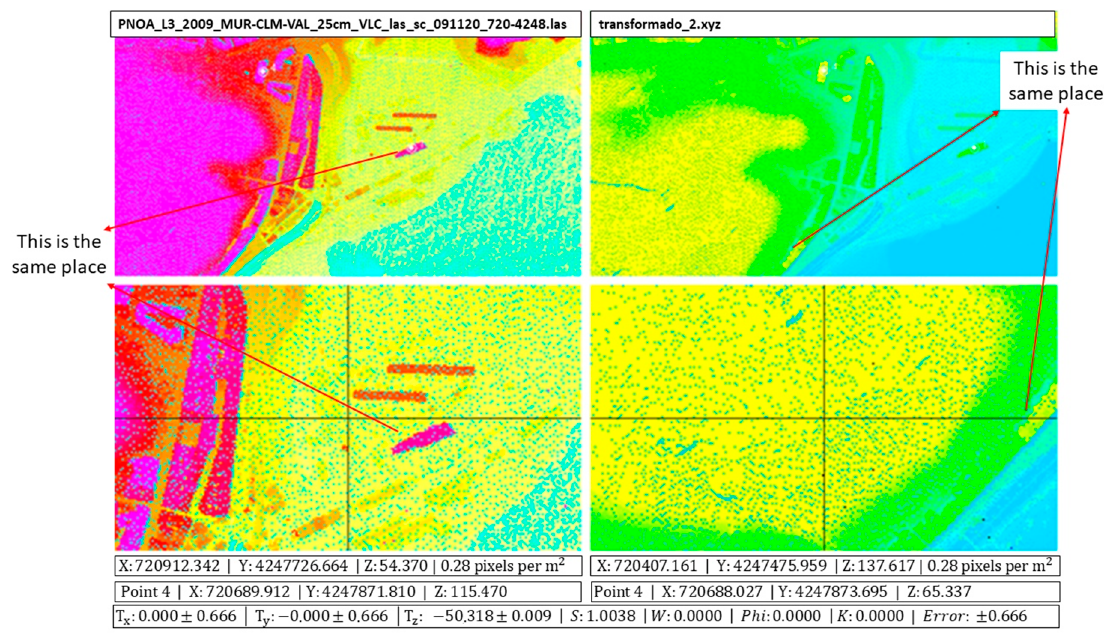
Figure 10. Screenshot of the hypsometric analysis with the mean squared error. The software allows you to move the images independently. See the coordinates of two images on the button in the first box. The cross is only used to target a point.